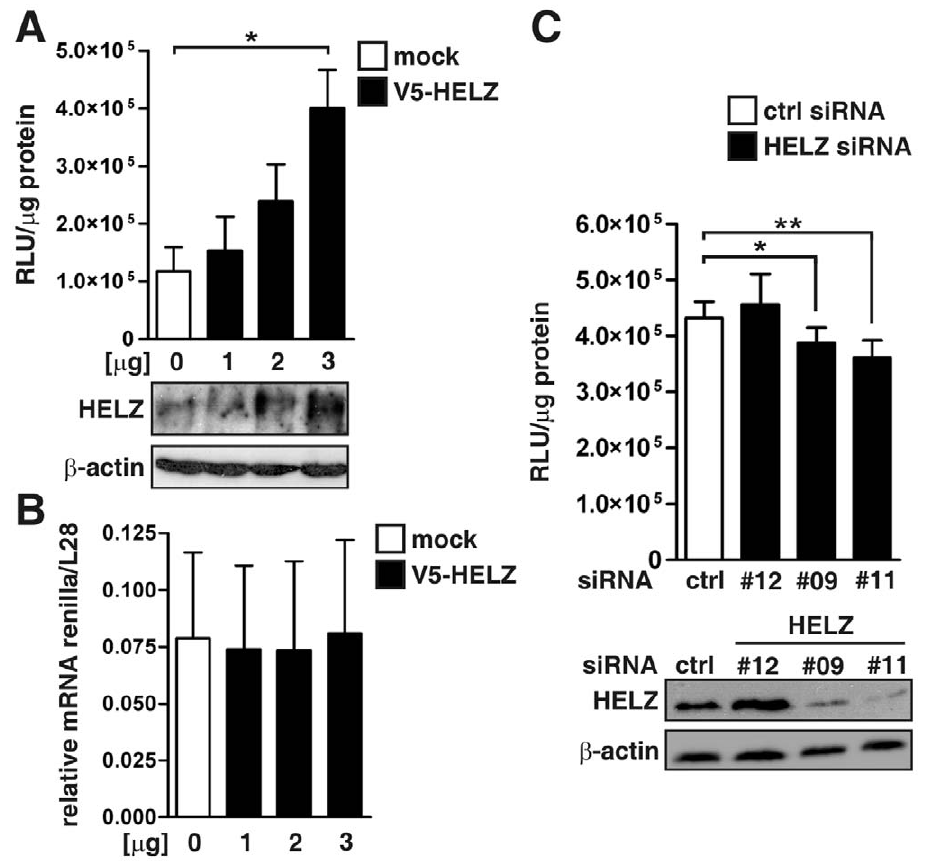
Figure 4. Translation of a luciferase reporter gene plasmid is regulated by HELZ. ( A ) HeLa cells were transiently co-transfected with the indicated amounts of HELZ or a control expression vector together with pRL-SV40 renilla luciferase reporter vectors, and cultivated for 48 hours before relative luciferase activities were determined (upper panel). HELZ protein expression levels were controlled by immunoblotting (lower panel). ( B ) Renilla luciferase mRNA was measured by RT-qPCR from total RNA extracted in a duplicate experiment presented in ( A) . Prior to RT, RNA was DNase-treated to digest possibly remaining plasmid DNA. Renilla mRNA levels were normalized to ribosomal protein L28 mRNA levels. ( C ) MCF-7 cells were transfected with the indicated siRNA oligonucleotides and 24 hours later with pRL-SV40, and cultivated for 48 hours before relative luciferase activities were determined (upper panel). HELZ knock-down efficiency was controlled by immunoblotting. Results are presented as mean values 6 standard error of the mean of n=3 ( A ) and n=6 ( C ) independent experiments,